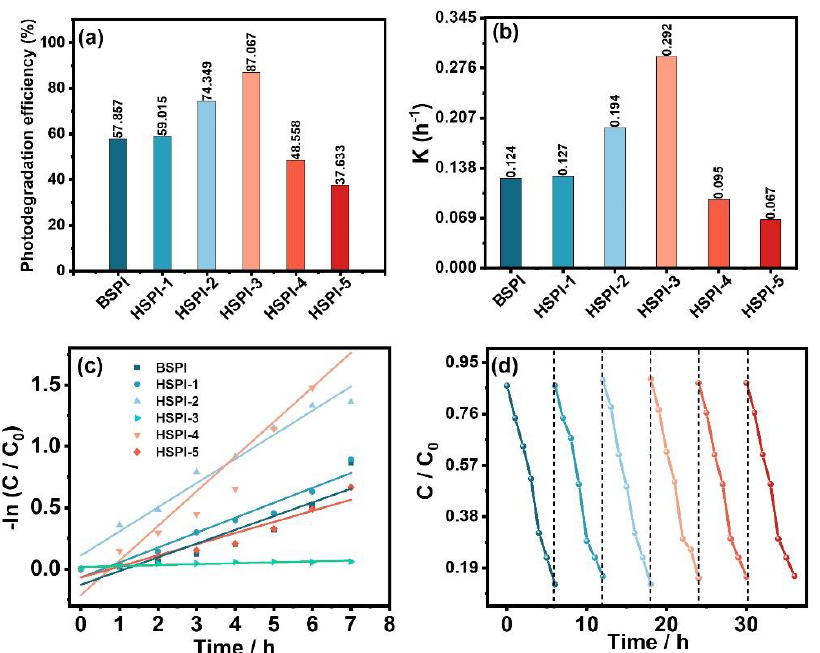
Figure 8. ( a ) Comparison of the photocatalytic degradation of efficiency MO over different catalysts under full arc light ( λ > 300 nm). ( b ) The calculated correspondence of different systems. ( c ) Kinetic constants of MO degradation with different systems. ( d ) Cycling running for the photocatalytic degradation of MO over the HSPI-3 sample